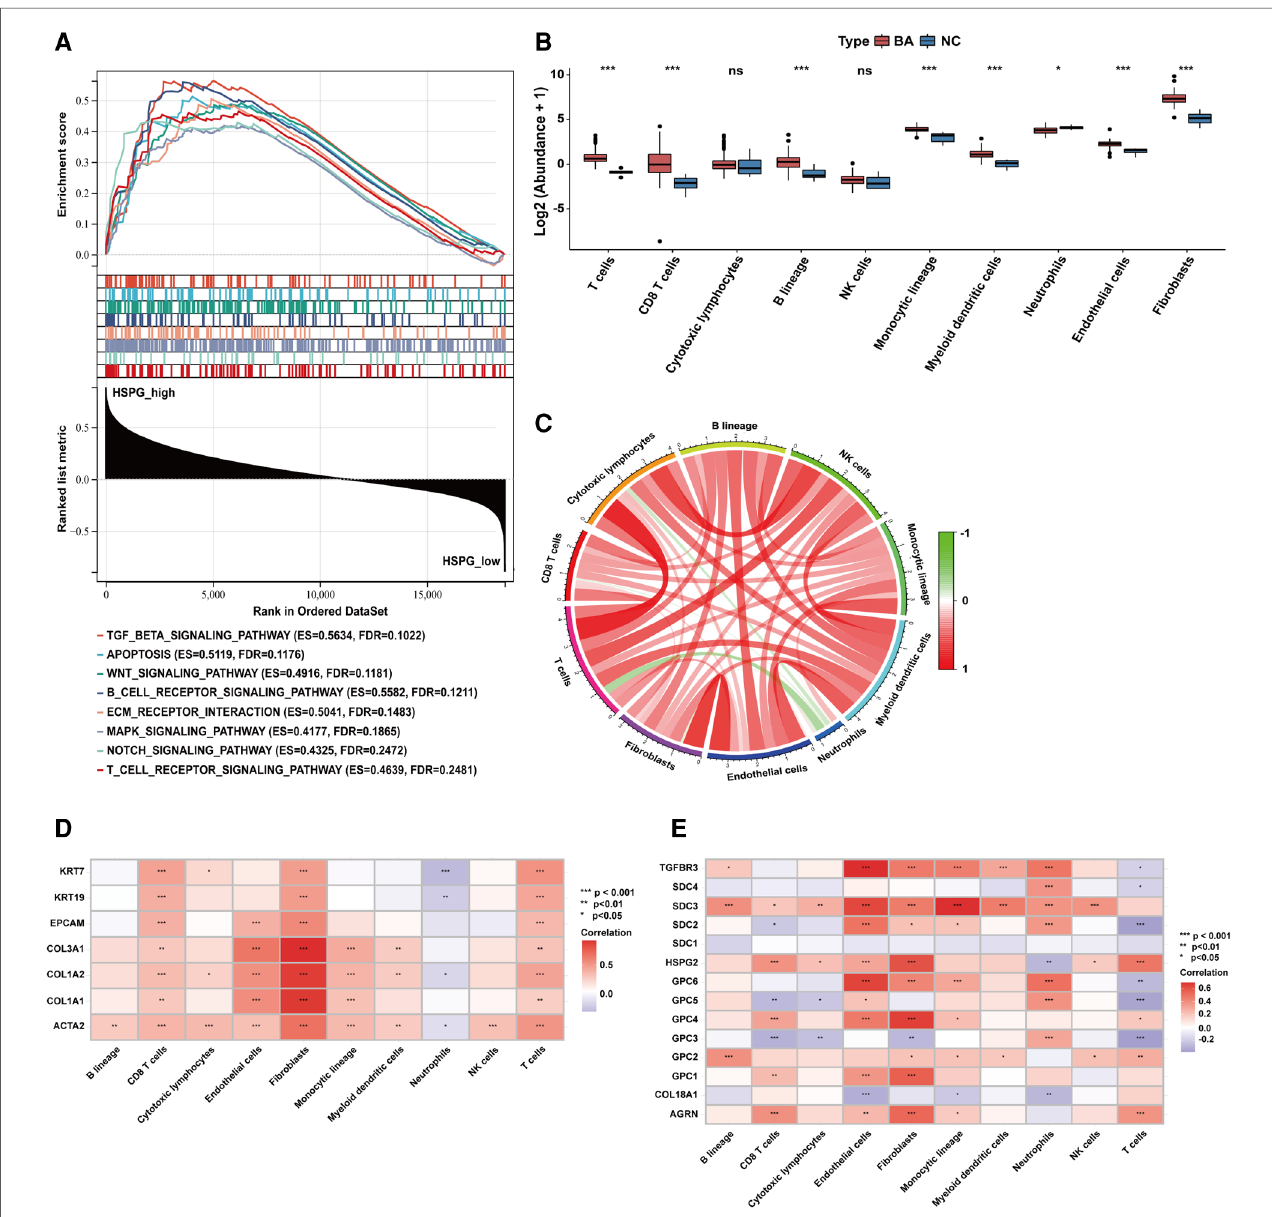
FIGURE 3 Immunocytes in fi ltration in BA and NC livers. ( A ) GSEA of BA patients classi fi ed in 2 groups based on HSPGs ssGSEA enrichment score. ( B ) The composition and abundance of immunocytes calculated by MCPcounter. ( C ) Correlation between immunocytes abundance in BA. ( D ) Correlation between immunocytes abundance, liver fi brosis and ductular reaction markers in BA. Red represents higher correlation and blue represents lower correlation, respectively. ( E ) Correlation between immunocytes abundance and HSPGs in BA. BA, biliary atresia; NC, normal control; GSEA, gene set enrichment analysis; HSPG, heparan sulfate proteoglycan; MCPcounter, microenvironment cell population-counter. * p <0.05, ** p <0.01, *** p